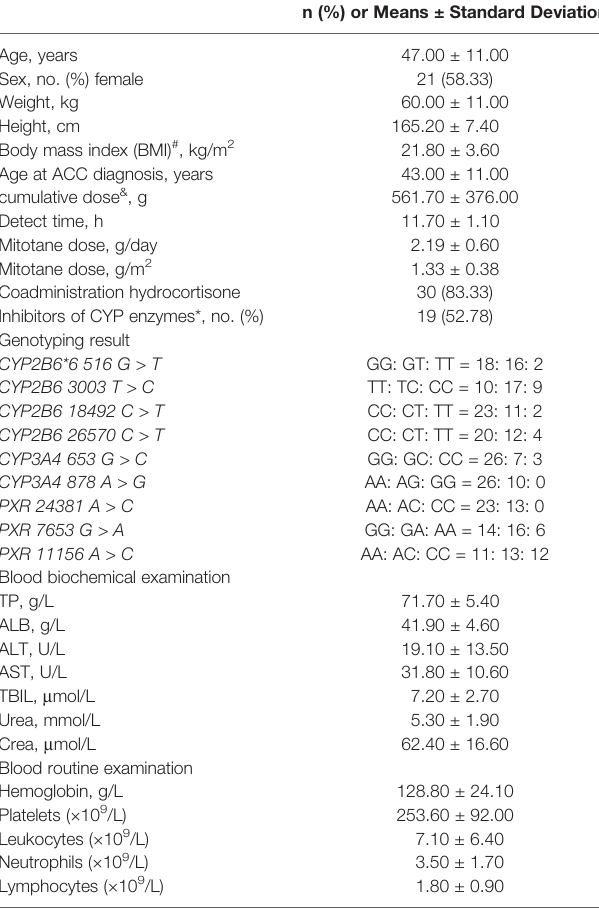
TABLE 1 | Baseline characteristics and genotype frequencies of SNPs of Chinses ACC patients in the present study. n (%) or Means ± Standard